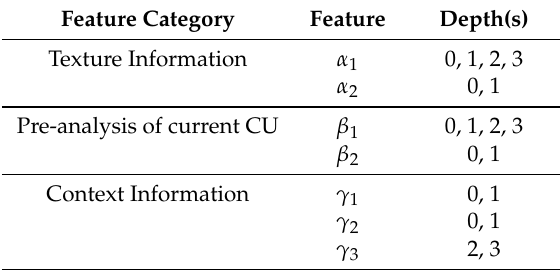
Table 1. Features used for different CU depth levels